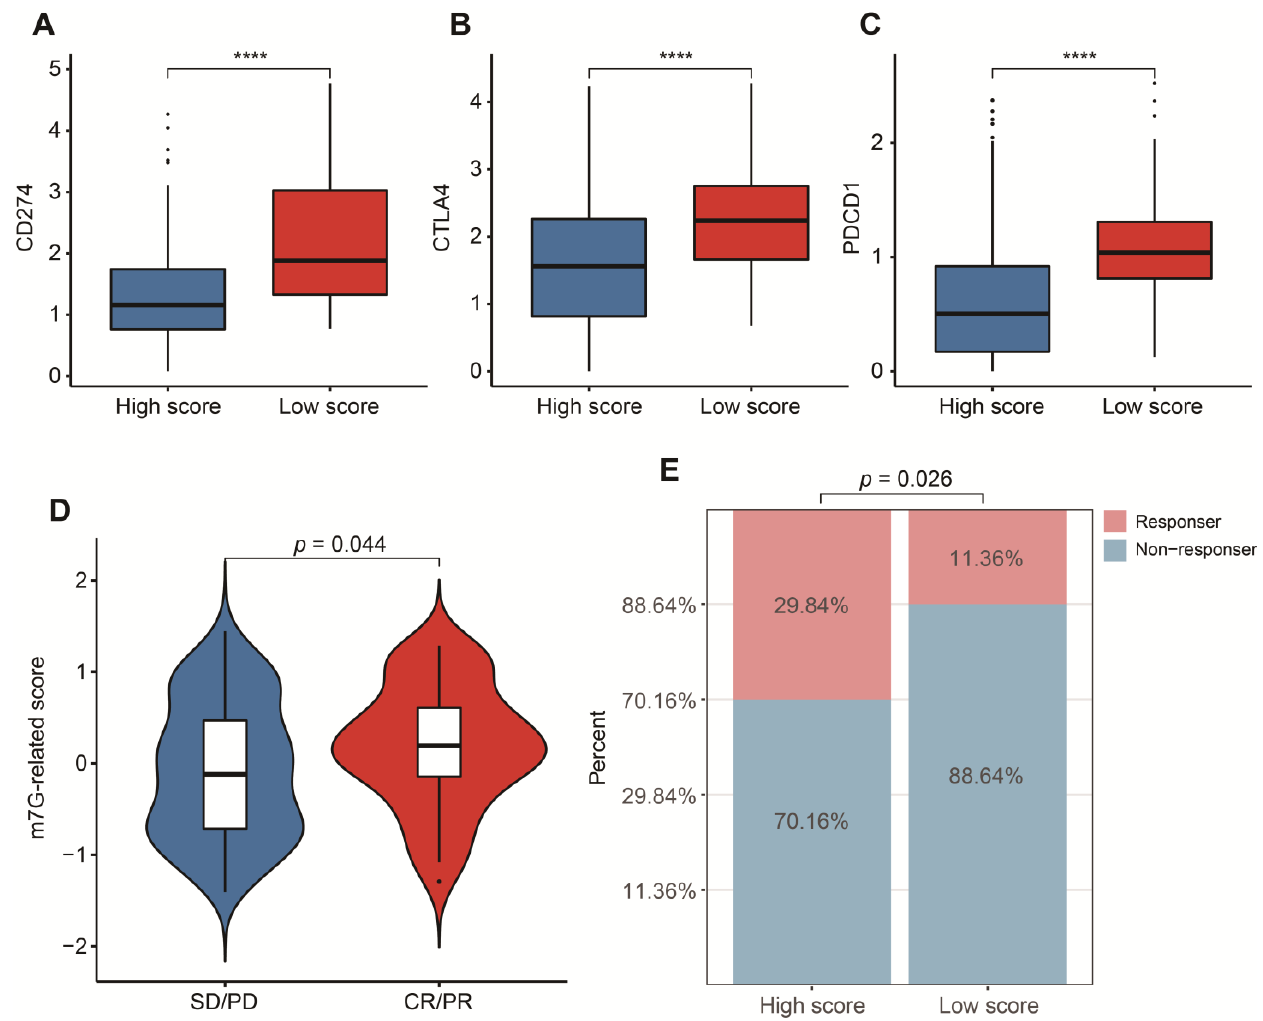
Figure 8. Validation in a real immunotherapy cohort. ( A ) Box plots of CD274 between high- and low-score groups. ( B ) Box plots of CTLA4 between high- and low-score groups. ( C ) Box plots of PDCD1 between high- and low-score groups. ( D ) Distribution of m7G-related scores between responders and non-responders. ( E ) Comparison of overall response rate between high- and low-score groups. Data in ( A – C ) were analyzed by Wilcoxon test; **** p < 0.0001.